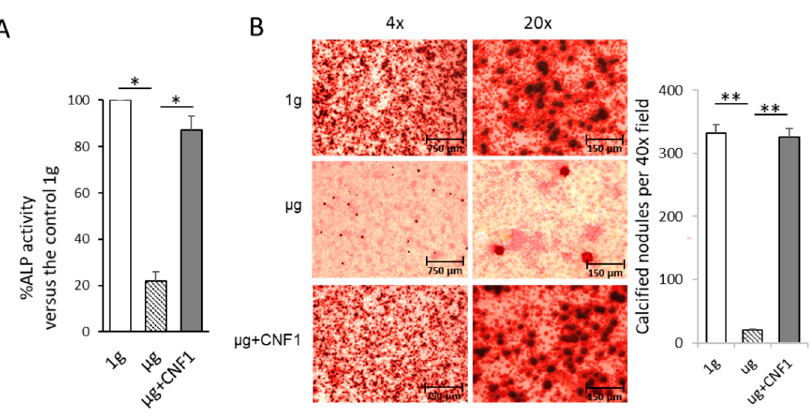
Figure 3. Assessment of ALP activity and mineralization in MC3T3-E1 cells cultured under different conditions. ( A ) Lysates of MC3T3-E1 cells cultured in flasks under 1 g, µ g and µ g + CNF1, respectively, were subjected to ALP activity analysis. Data represent the mean of a triplet ± SD in three experiments. * p < 0.05 versus different groups by Student t test. ( B ) MC3T3-E1 cells cultured in chamber slides under 1 g, µ g and µ g + CNF1, respectively. The cells on slides were fixed with 4% paraformaldehyde and then stained for 30 min with Alizarin red at 37 ◦ C, followed by measurement of Alizarin-red-stained calcified nodules (mineralization) by light microscopy. The calcified nodules per 40 × field were measured by using ImageJ software. Data represent the mean ± SD. ** p < 0.01 versus different groups by using Student t test. One representative experiment of two is shown.